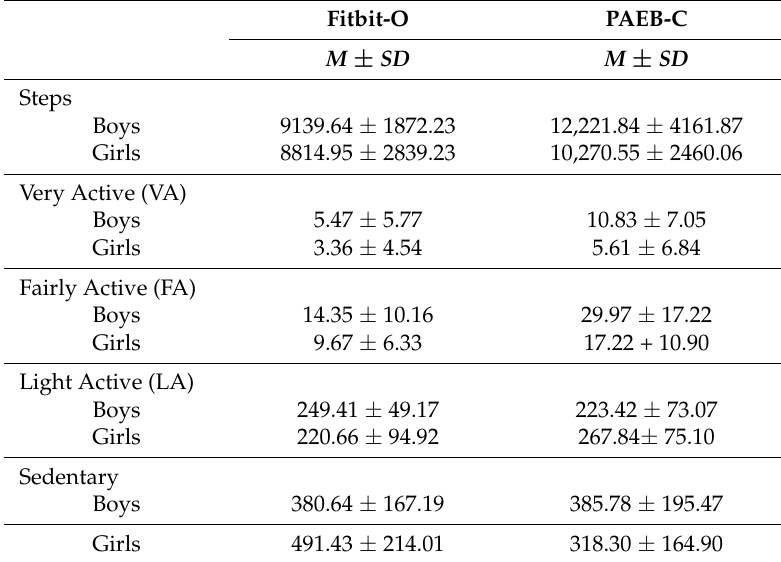
Table 2. Descriptive statistics of five Fitbit variables by groups and gender.